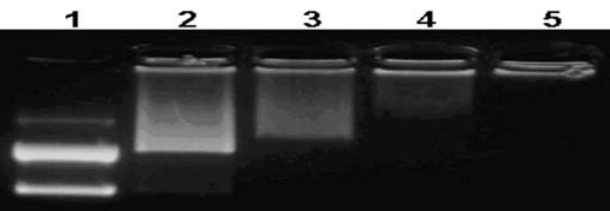
Figure 3. Agarose gel electrophoresis retardation of pGL3 plasmid DNA by HP α -CD-PEI. Lane numbers correspond to HP α -CD-PEI/DNA at different N/P ratios: (1) 0:1 (DNA only), (2) 1:1, (3) 2:1, (4) 4:1, (5)